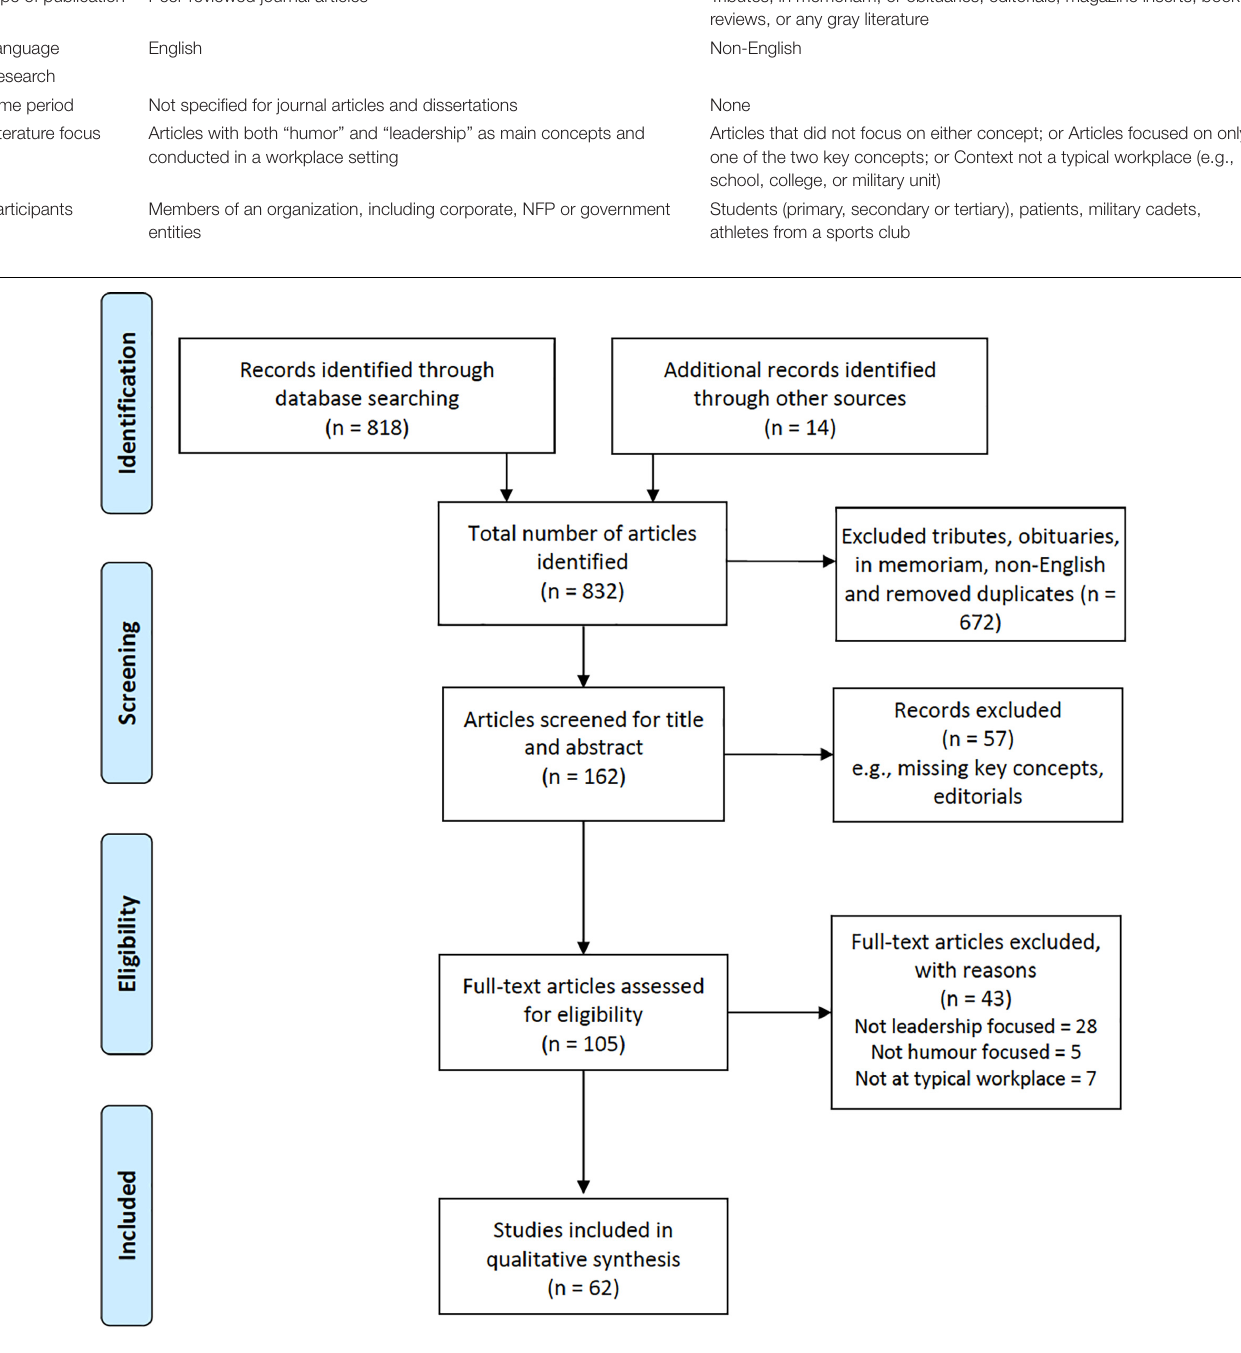
FIGURE 1 | PRISMA flow diagram for searching and screening